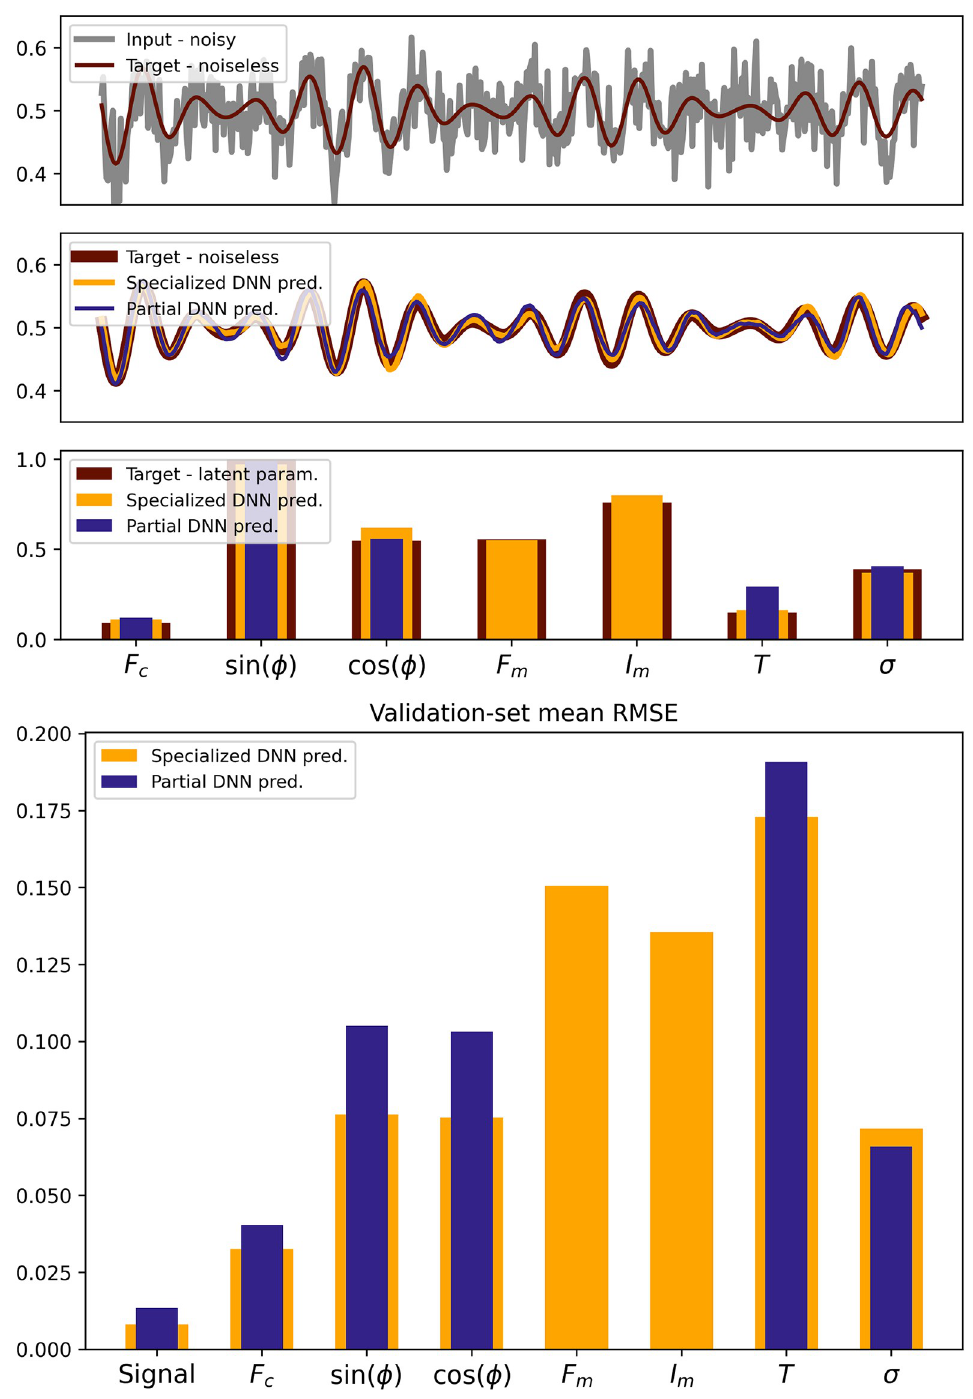
Fig 5. Performance comparison of the specialized DNN (trained on AM-sine waves, tasked to denoise signals and recover all latent parameters of AM-sine waves) and of the partial DNN (trained on monochromatic, AM- and FM- sine waves, tasked to denoise signals and recover the carrier frequency, phase, coherence time and noise level only). Top : Randomly selected example of noisy input AM-signal, alongside specialized- and partial-DNN denoised and latent predictions. Bottom : Individual latent parameters and signal denoising root mean squared error (RMSE), averaged over the whole AM-sinewave test set (100 0 000 samples) for both DNNs.